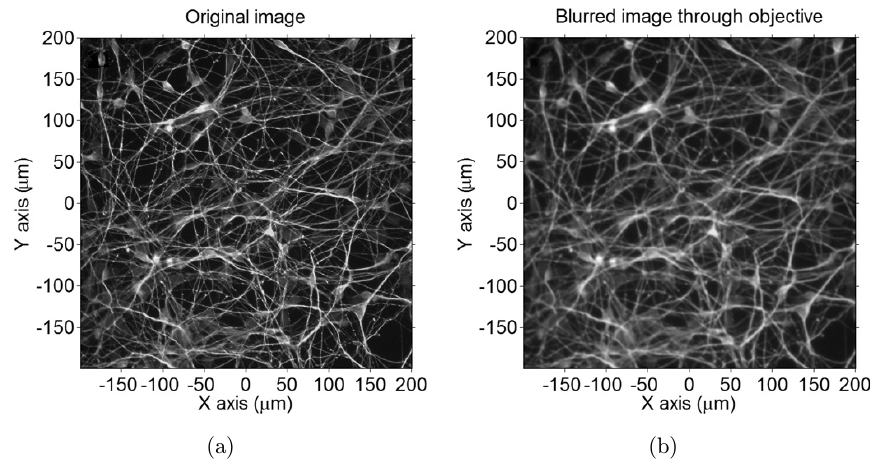
Fig. 2. Image blurred by the PSF of a conventional microscope.